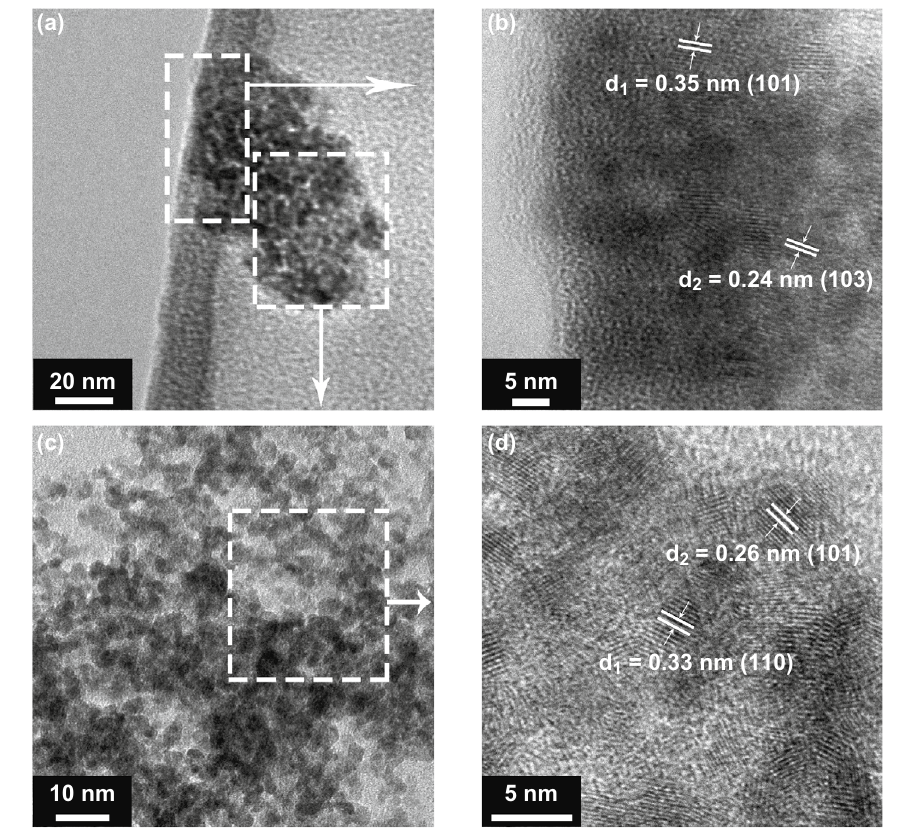
Fig. 4 a TEM image of MDCN sample. b HRTEM image for the magnified left dotted box in a . c TEM image for the magnified right dotted box in a . d HRTEM image for the enlarged region in dotted box in